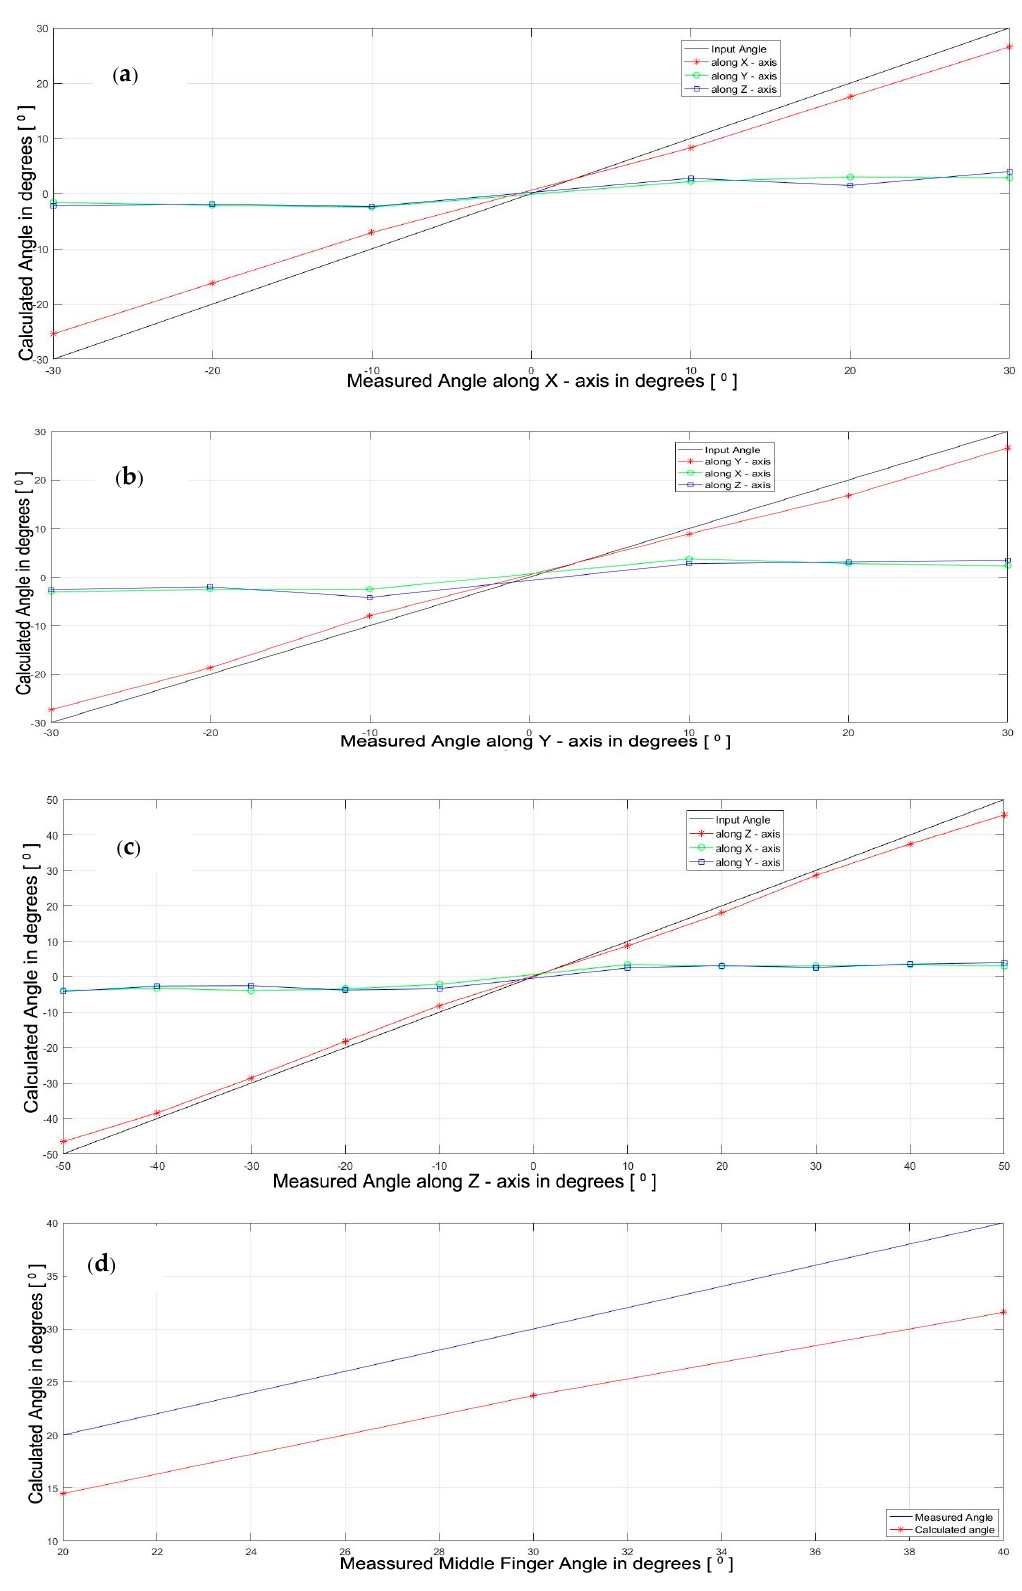
Figure 12. Different orientations of hand in front of LSSs: ( a ) hand held straight; ( b ) hand held upside down at an inclination; ( c ) fingers bend.